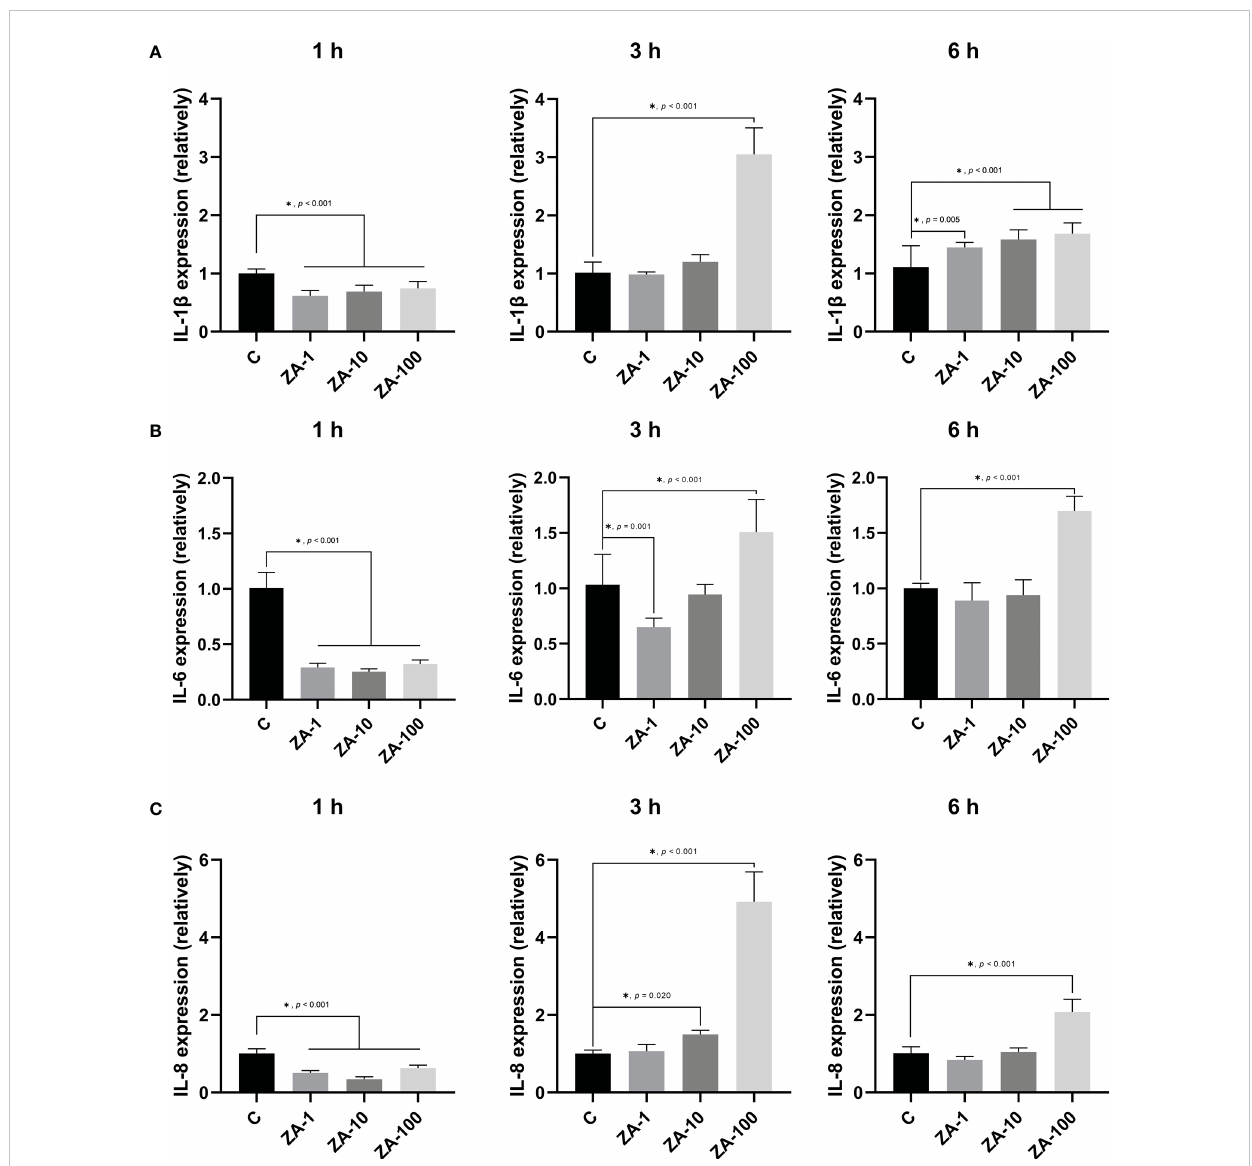
FIGURE 3 The relative mRNA expression levels of pro-in fl ammatory factors of HGECs. The relative mRNA expression levels of IL-1 b (A) , IL-6 (B) , and IL-8 (C) of HGECs after P. gingivalis infection for 1 h, 3 h, and 6 h of the 4 groups. n = 4 in each group. Values represent mean ± SD. Control, ZA-1, ZA-10, ZA- 100 represent 0 m M ZA, 1 m M ZA, 10 m M ZA, 100 m M ZA respectively. * p<